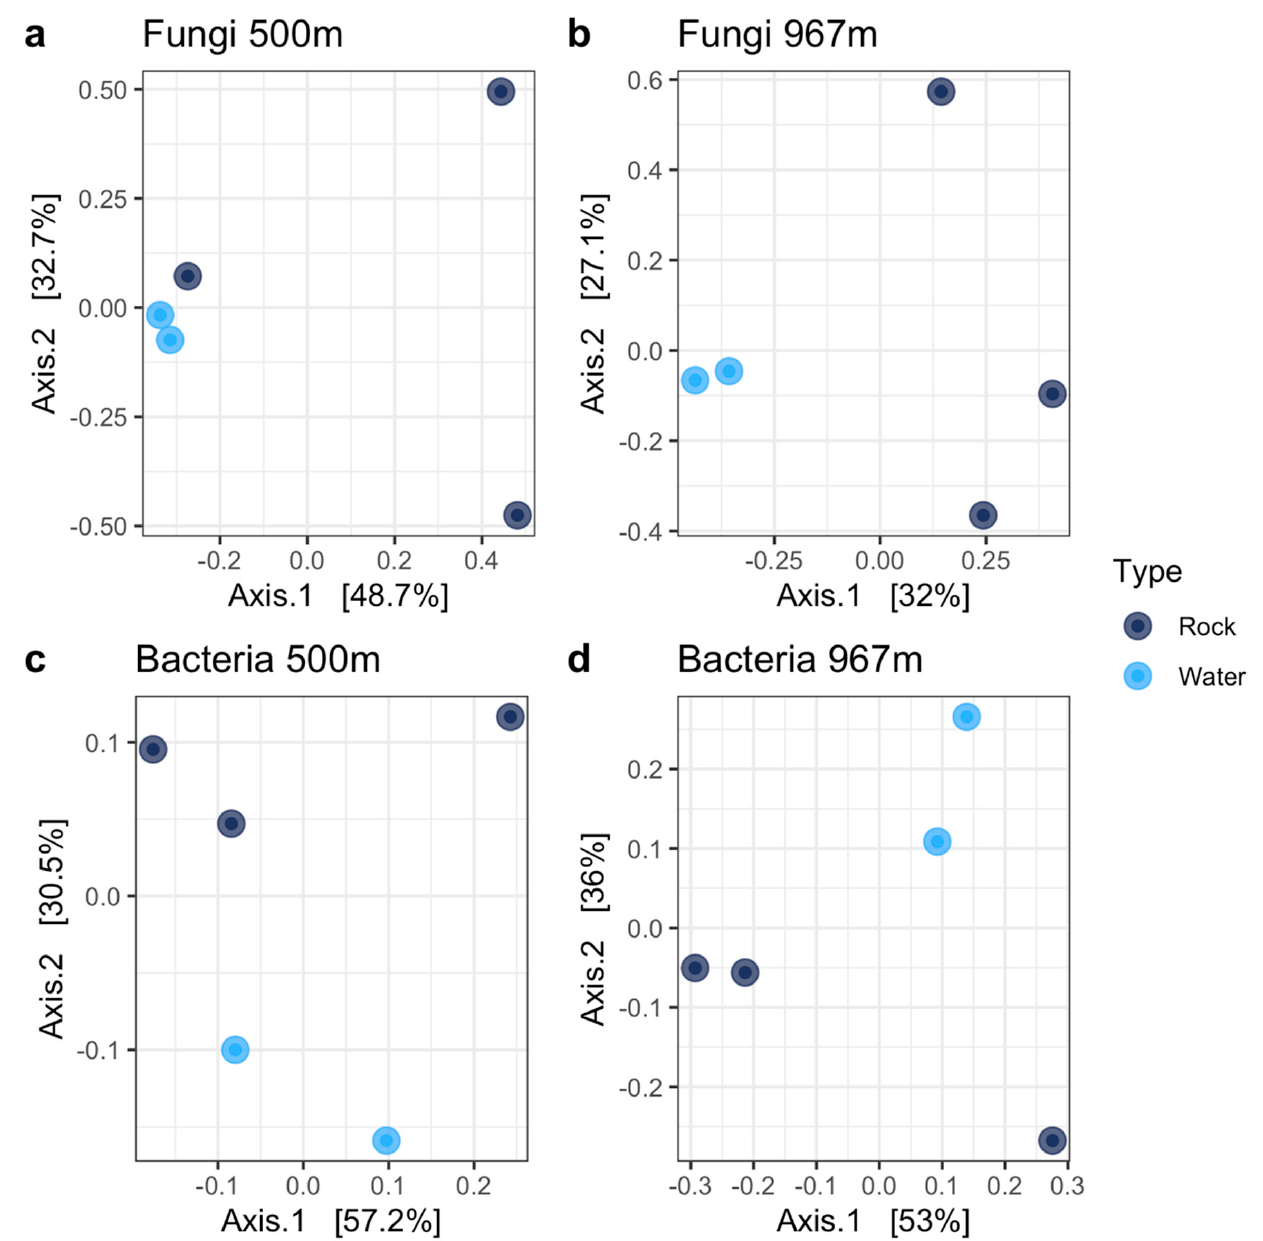
Figure 12. Comparison of microbial community composition in the closed traps were evaluated with PCoA. Fungal community composition in rock surface and water samples were analyzed from the depths of 500 m ( a ) and 967 m ( b ) and bacterial community composition at the depths of 500 m ( c ) and 967 m ( d ).